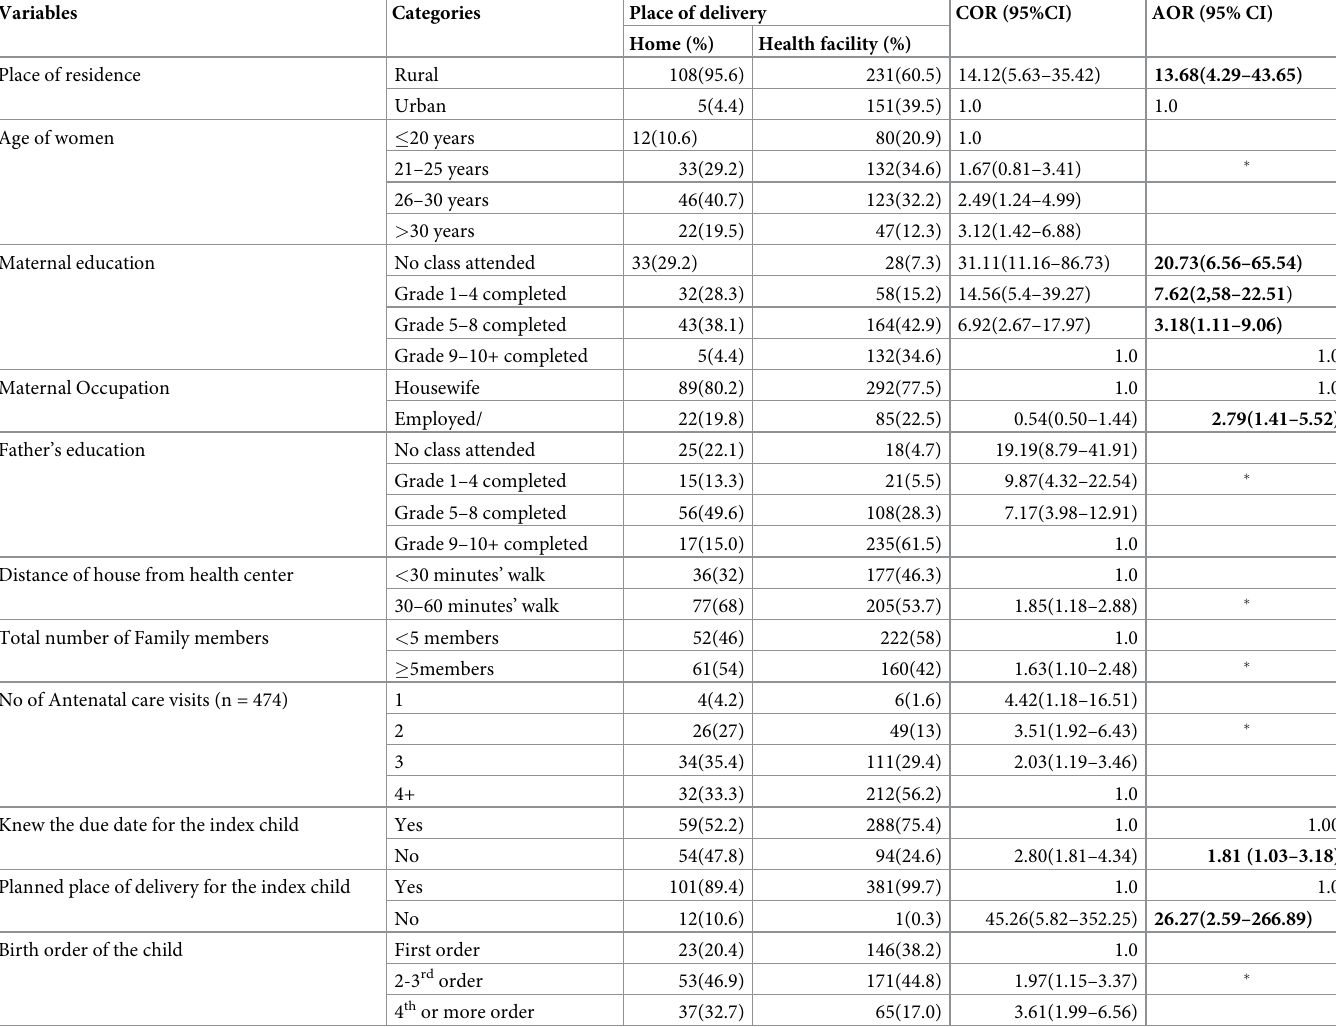
Table 3. Bivariate and multivariate analyses of factors associated with home deliveries at KMC implementation sites, Sidama Administration,